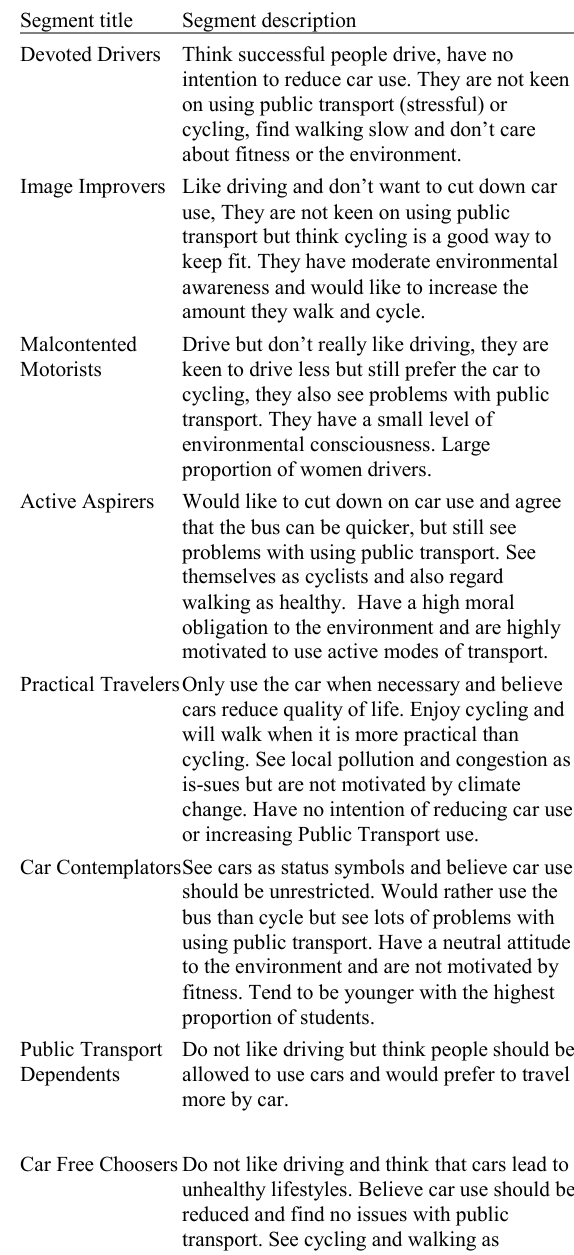
Table 1. Segmentation of people based on mobility attitudes, from Anable